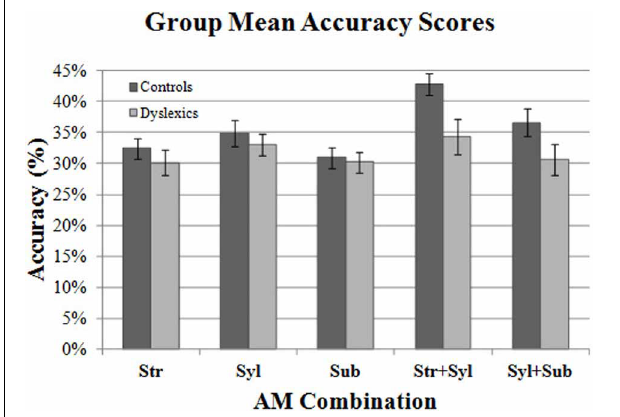
FIGURE 4 | Group mean Accuracy scores for each AM band and band combination. Error bars indicate standard error.